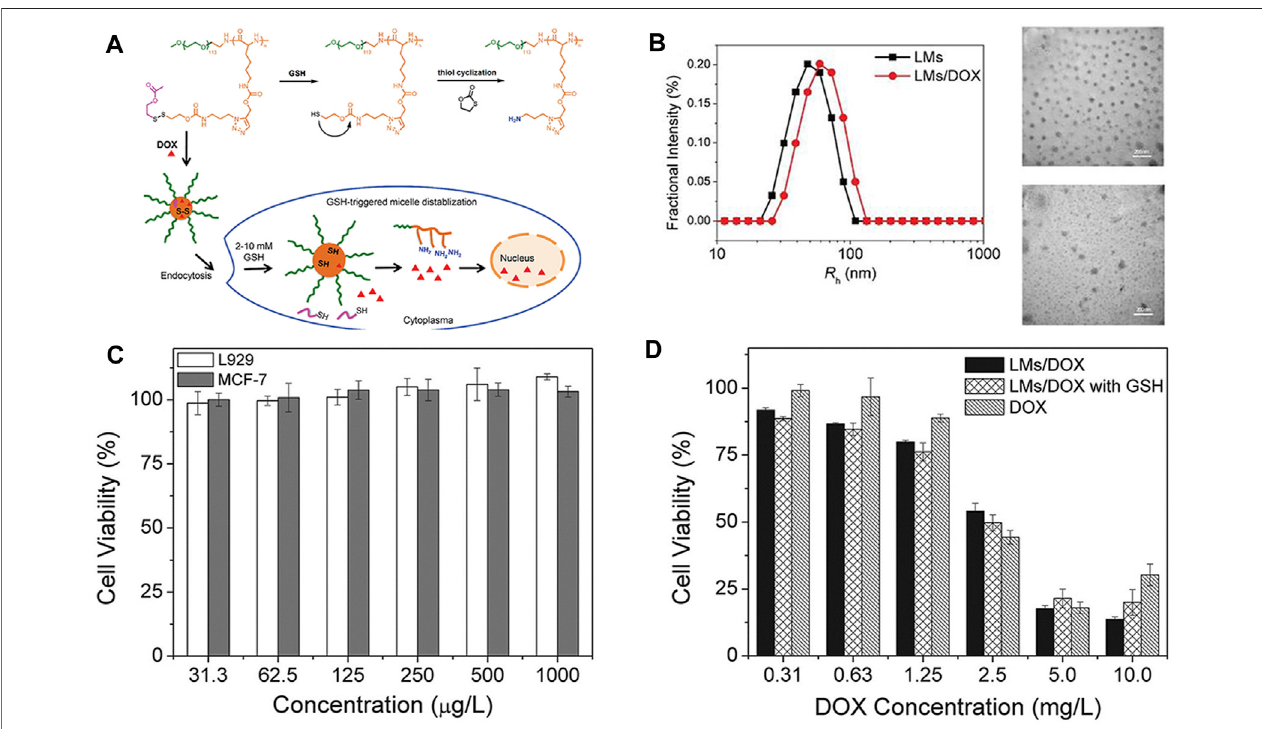
FIGURE 4 | Chemical structure of the PEG 113 -bP (Lys-DSA) polymer thiol reaction and in vitro and in vivo experimental characterizations (Yao et al., 2019). (A) Schematic diagram of the chemical structure of the polymer thiol reaction and the reduction-sensitive DOX release behavior after LMs/DOX endocytosis. (B) Hydrodynamic radius and TEM images of blank and drug-loaded nanogels. (C) Cytotoxicity of nanogels on L929 cells and MCF-7 cells in vitro . (D) Cytotoxicity of DOX- loaded nanogels and free